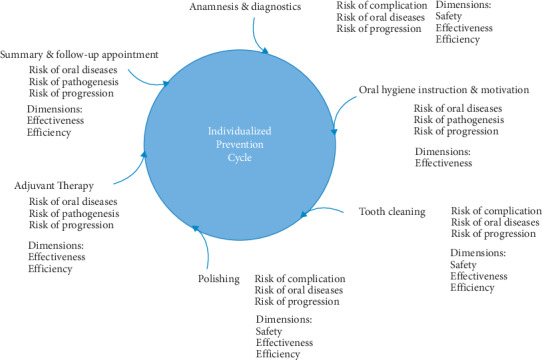
The practical implication of the concept of individualized prevention. Each basic element of the prevention session is influenced in its content and general framework by the four different risks within the case-oriented profile. The main risks within the six basic elements are presented alongside the primary related dimensions.